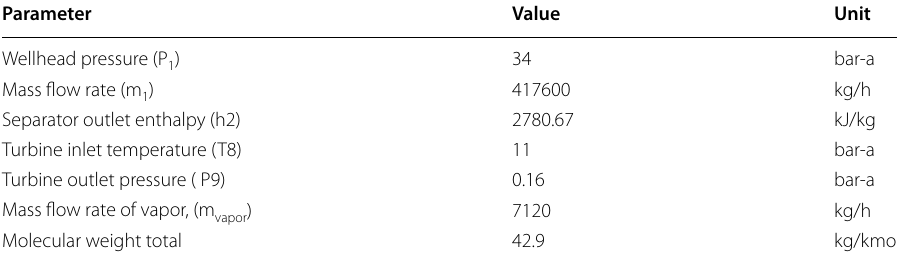
Table 3 Data and assumptions of Kamojang GPP’s Unit